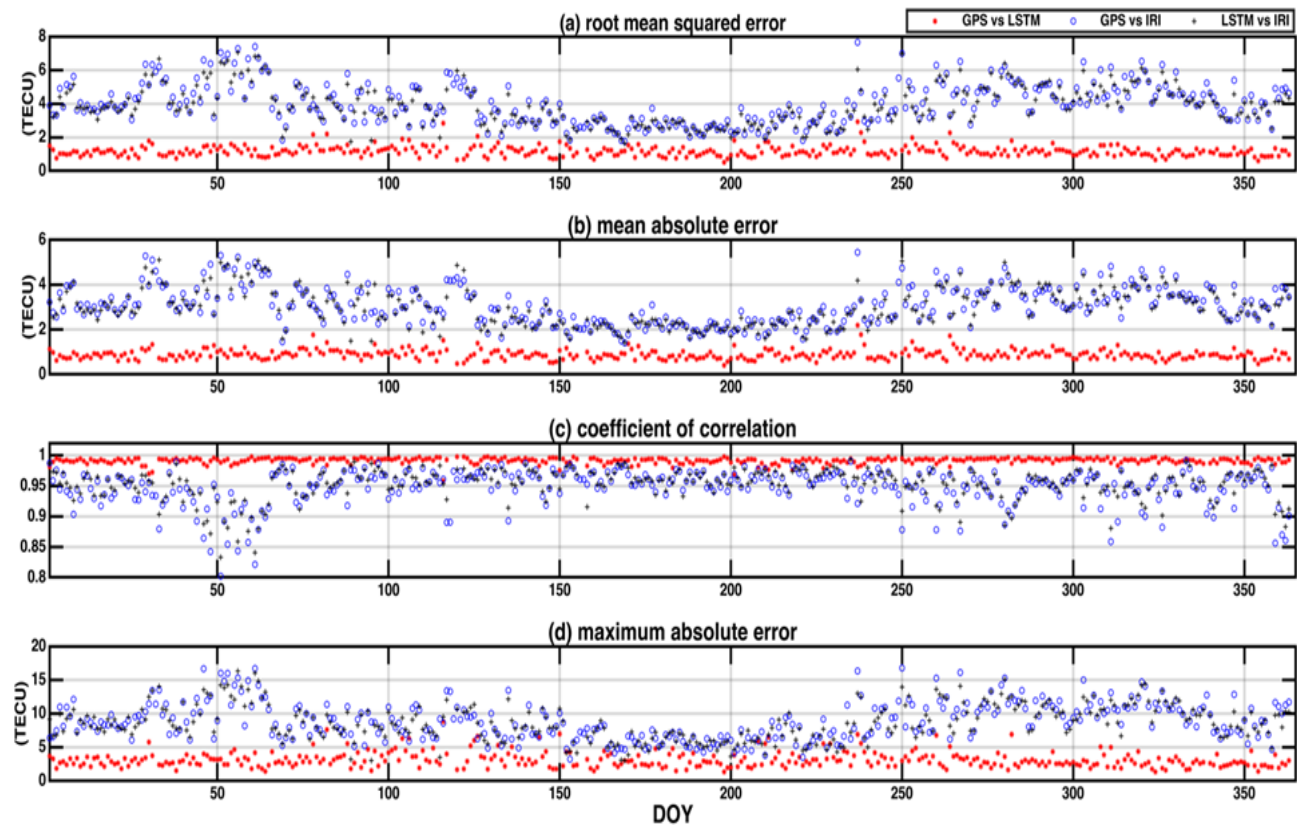
Figure 7. Scatter plots of ( a ) root mean square error (RMSE), ( b ) mean absolute error (MAE), ( c ) coefficient of correlation (CC), ( d ) maximum absolute error of GPS vs. LSTM, GPS vs. IRI, and LSTM vs. IRI at a low latitude station Bangalore (IISC) in India.